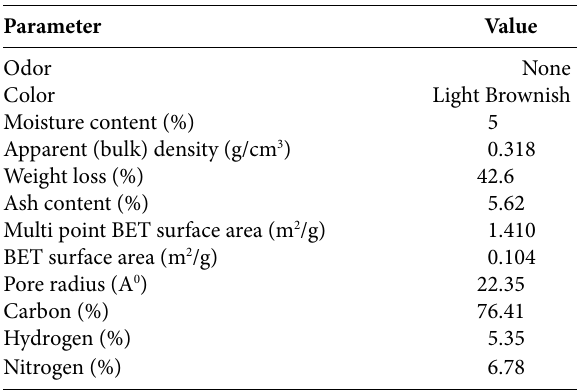
Table 1. Elemental analysis, physical and surface characterization of PBP